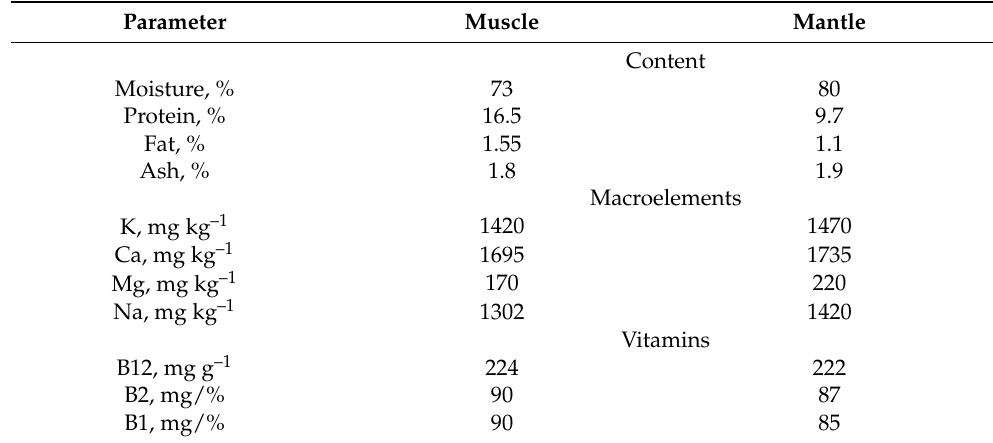
Table 2. Biochemical composition and microelement and vitamin content in muscles and mantles of wild yesso scallops from the Sea of Japan